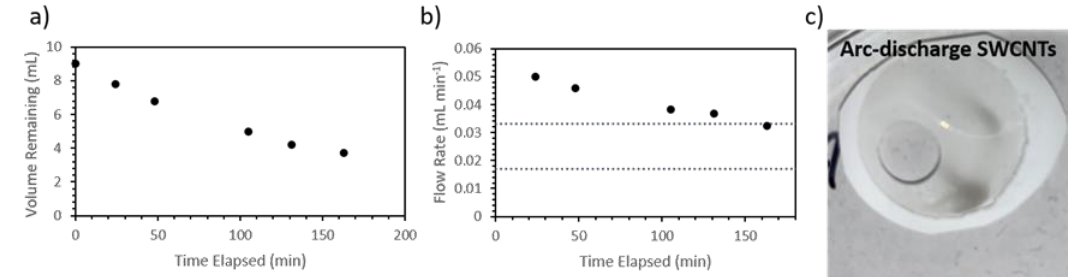
Figure 2. ( a ) Volume loss with time for gravity filtration of 100 µL aliquot of an arc-discharge SWCNT suspension diluted up to 10 mL with water following brief water filtration under vacuum. ( b ) Flow rate for gravity filtration of 100 µL aliquot of an arc-discharge SWCNT suspension diluted up to 10 mL with water following brief water filtration under vacuum, horizontal lines indicate the optimum flow rate as published by He et al. [34]. ( c ) Optical image of slow-filtered arc-discharge SWCNT film. The grey areas on the white membrane show the presence of SWCNTs. The darker the shade, the denser the nanotubes are on the surface. The void in the film is where a section was removed for testing.